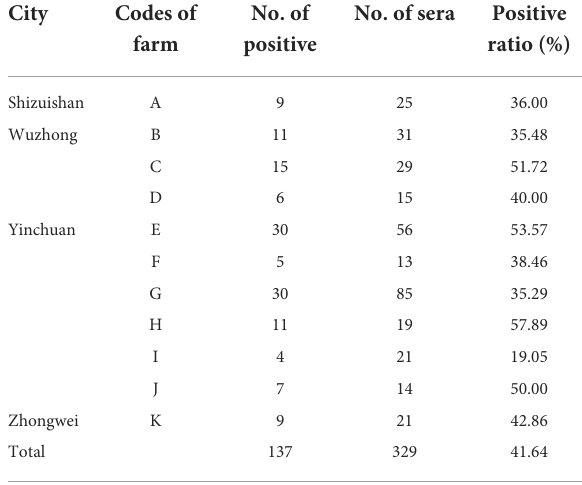
TABLE 2 Sensitivity, specificity and kappa-value of ELISA compared to IFAT and WB.